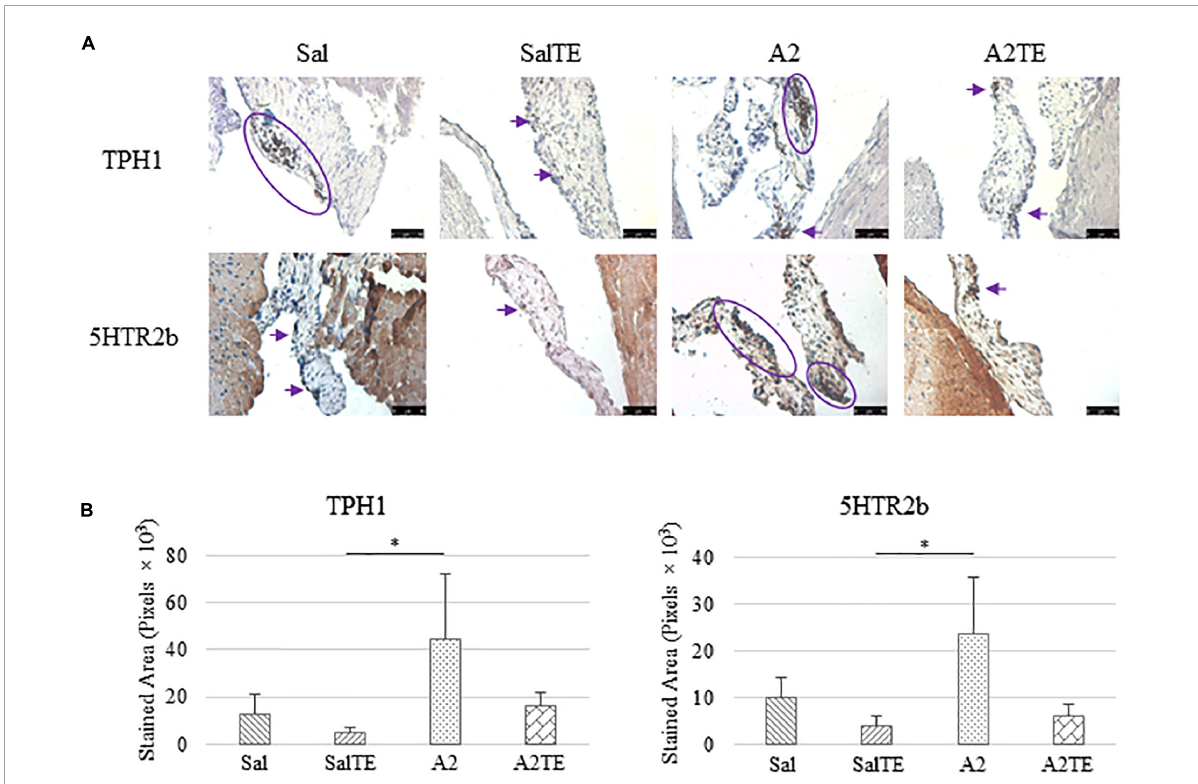
FIGURE7 (A) Investigation of local serotonin signaling in mitral valve by IHC examinations on TPH1 and 5HTR2b in prevention study. Major positive IHC stains were highlighted by circles and arrows. Scale bar: 50 µ m. (B) Quantification of their expression determined by total stained area in pixels that measured from 4 biological replicates in MATLAB. Asterisk indicates significant difference ( p <